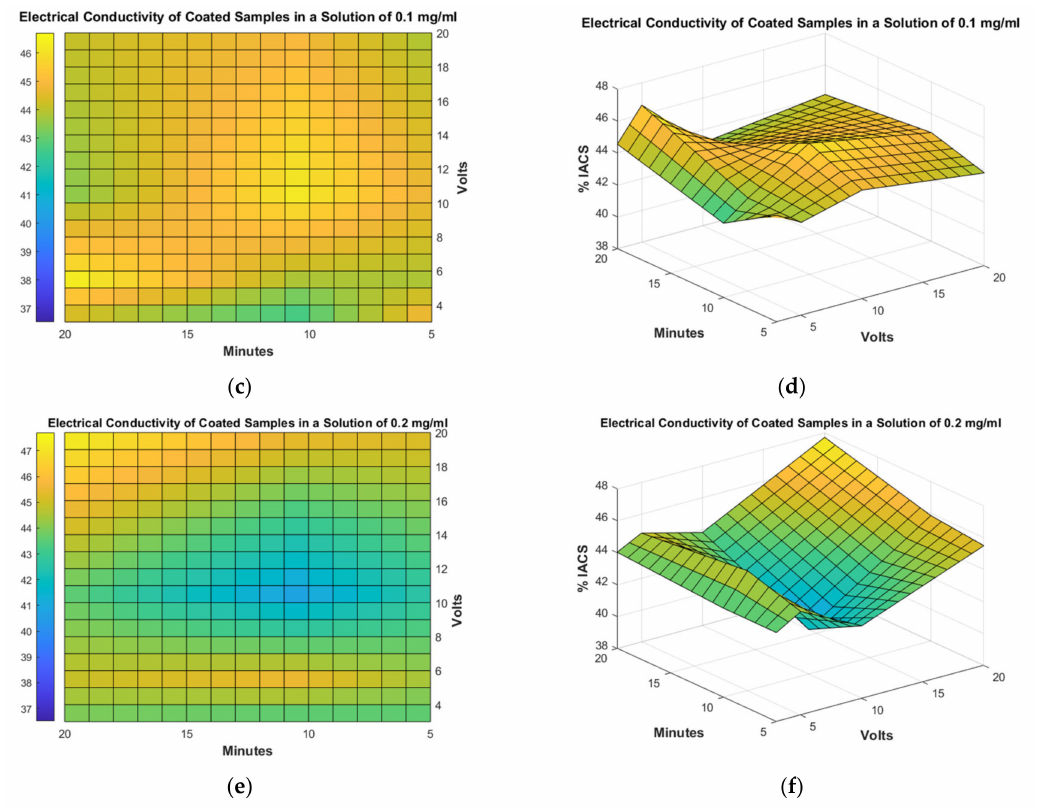
Figure6. Electricalconductivity(%IACS)measurementsperformedatdi ff erentMWCNTconcentrations. ( a ) Top view and ( b ) schematic view of the %IACS for metallic samples coated in a solution of 0.05 mg / mL of MWCNT. ( c ) Top view and ( d ) schematic view of the %IACS for metallic samples coated in a solution of 0.10 mg / mL of MWCNT. ( e ) Top view and ( f ) schematic view of the %IACS for metallic samples coated in a solution of 0.20 mg / mL of MWCNT. Experimental results show that electrical conductivity on the surface of the coated Al6061 samples improves them with lower deposition times and applied voltage for small solution concentrations of MWCNT used in EDP. For higher concentration solutions of 0.20 mg / mL of MWCNT, the %IACS increases for higher voltages and prolonged deposition times.